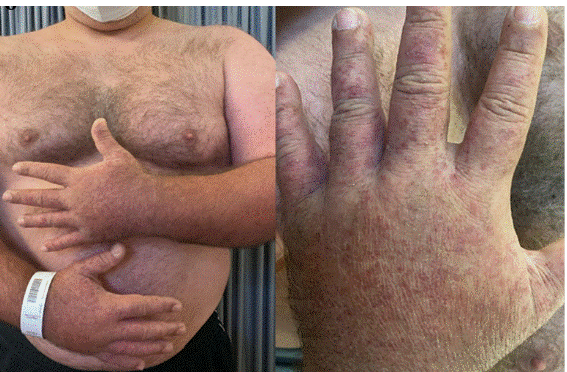
Figure 6. Diffuse papular–pustular lesions after second dose of Pfizer-BioNTech vaccine.